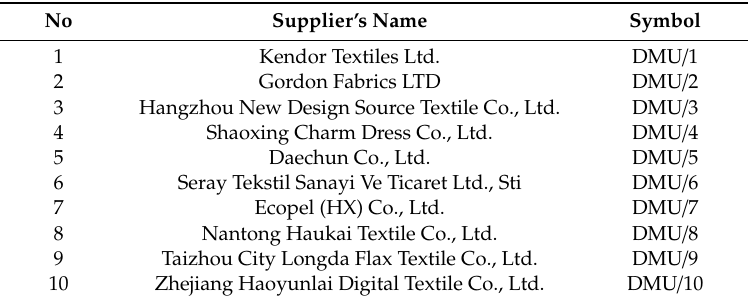
Table 1. The identification symbols of ten fabric suppliers.